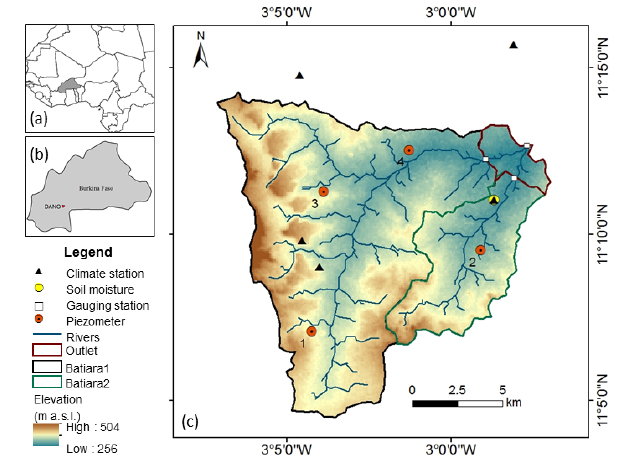
Figure 1. Location and instrumentation map of the Dano catch- ment.